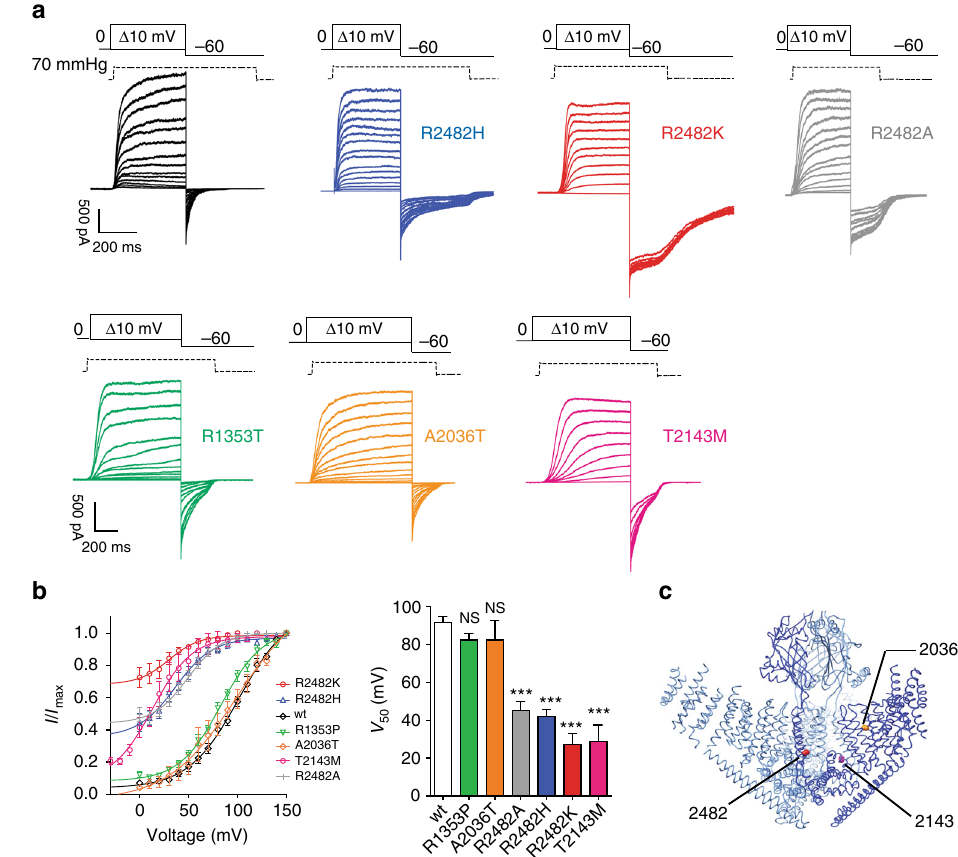
Fig. 4 Mutations causing xerocytosis in humans alter voltage modulation of PIEZO1. a Current responses to a pressure stimulation of 70 mmHg during 300 ms voltage steps ranging from 0 to 150 mV, followed by a repolarization step to − 60 mV to obtain tail currents for wild-type PIEZO1 (black), R2482H (blue), R2482K (red), R1353T (green), A2036T (orange), T2143 (magenta), and R2482A (gray) mutants. The R2482K mutant shows decreased voltage modulation. b Tail currents from individual cells were normalized to their maximum and fi tted to a Boltzmann relationship (wt: V 50 = 91.9 ± 3.2 mV, slope 22.2 ± 0.9, 12 cells; R2482H V 50 = 42.0 ± 3.7 mV, slope 14.4 ± 1.5, 19 cells; R2482K V 50 27.2 ± 5.9 mV, slope 12.2 ± 1.5, 10 cells, R1353P V 50 = 82.4 ± 8.8